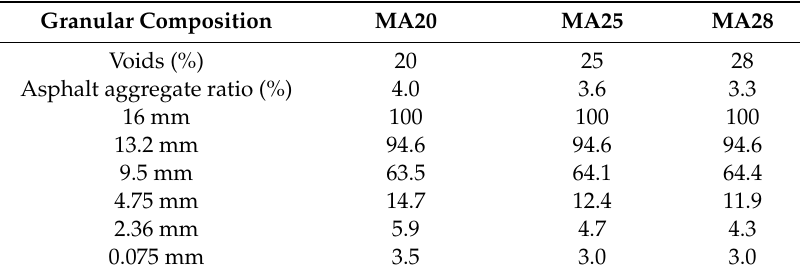
Table 5. Design of the matrix asphalt